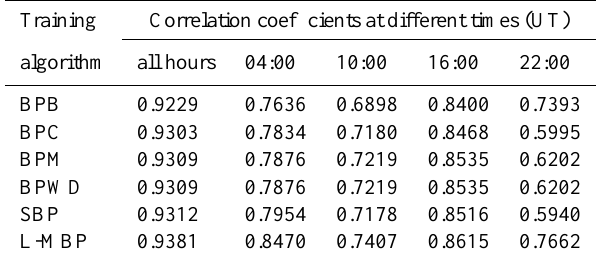
Table 2. Computed correlation coefficient values for SUTH in